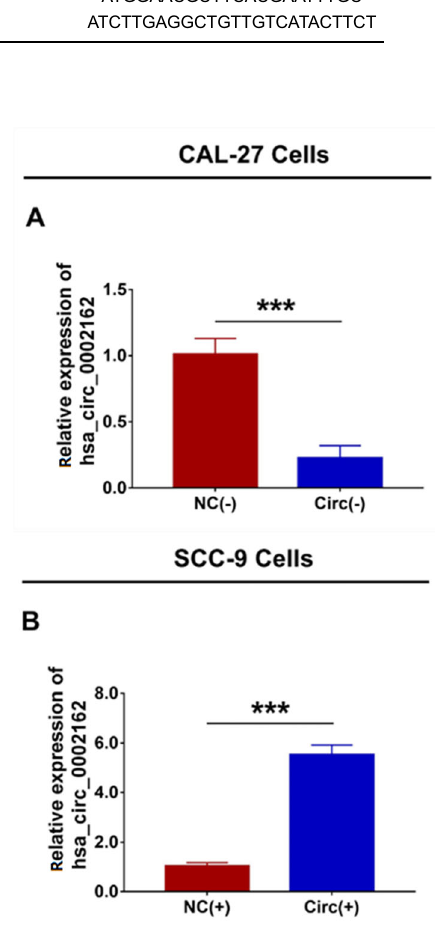
Figure 2. A , Comparison of hsa_circ_0002162 expression between the Circ( – ) group and the NC( – ) group. B ,